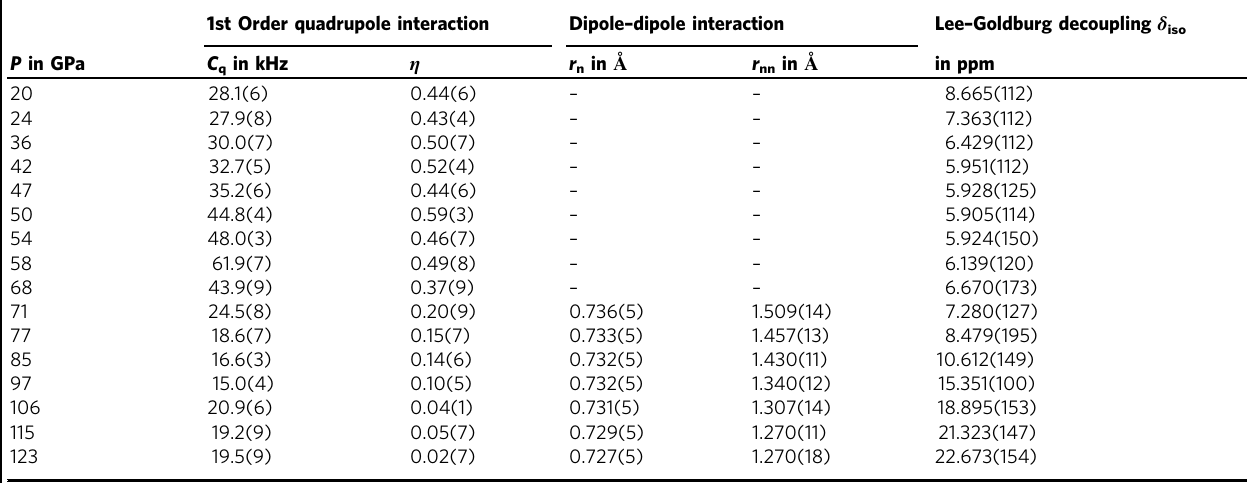
Table 1 Fitting parameters of 1 H-NMR